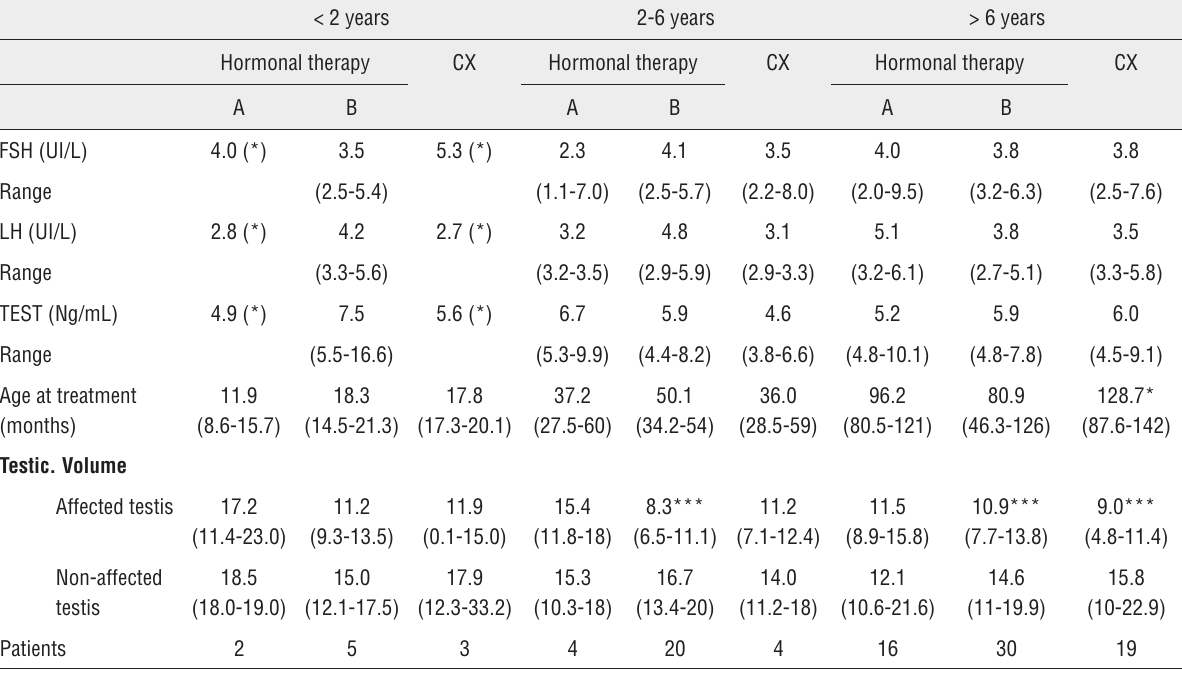
Table 2 - Unilateral cryptorchidism (n=103) Features based on age and therapy (A-only hormonal treatment; B-hormonal first and surgery later; CX – surgery alone;